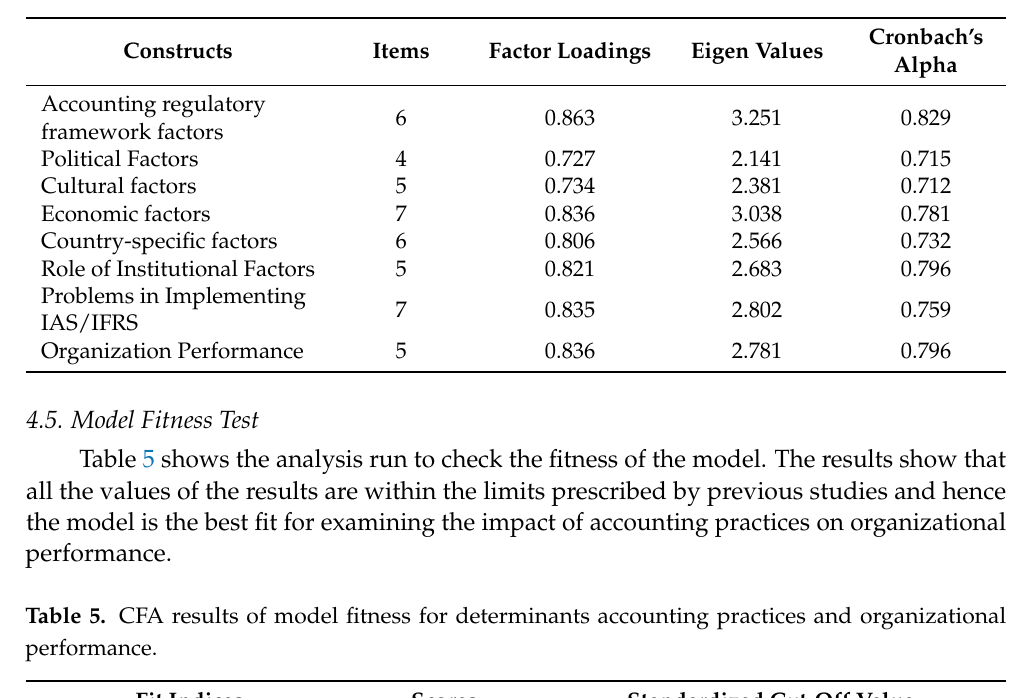
Table 4. Results of EFA and Cronbach’s Alpha.